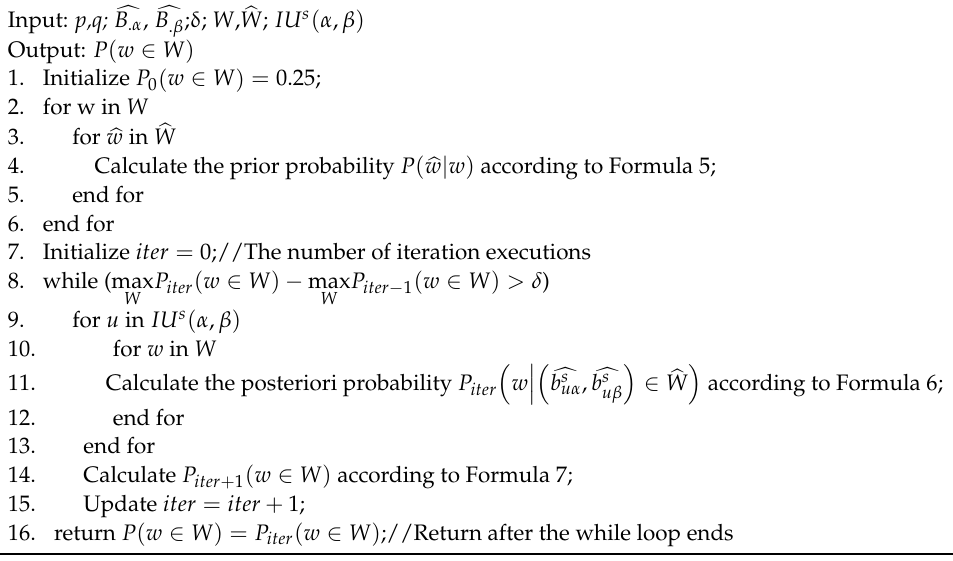
Algorithm 1: Joint distribution estimation algorithm based on Bayesian